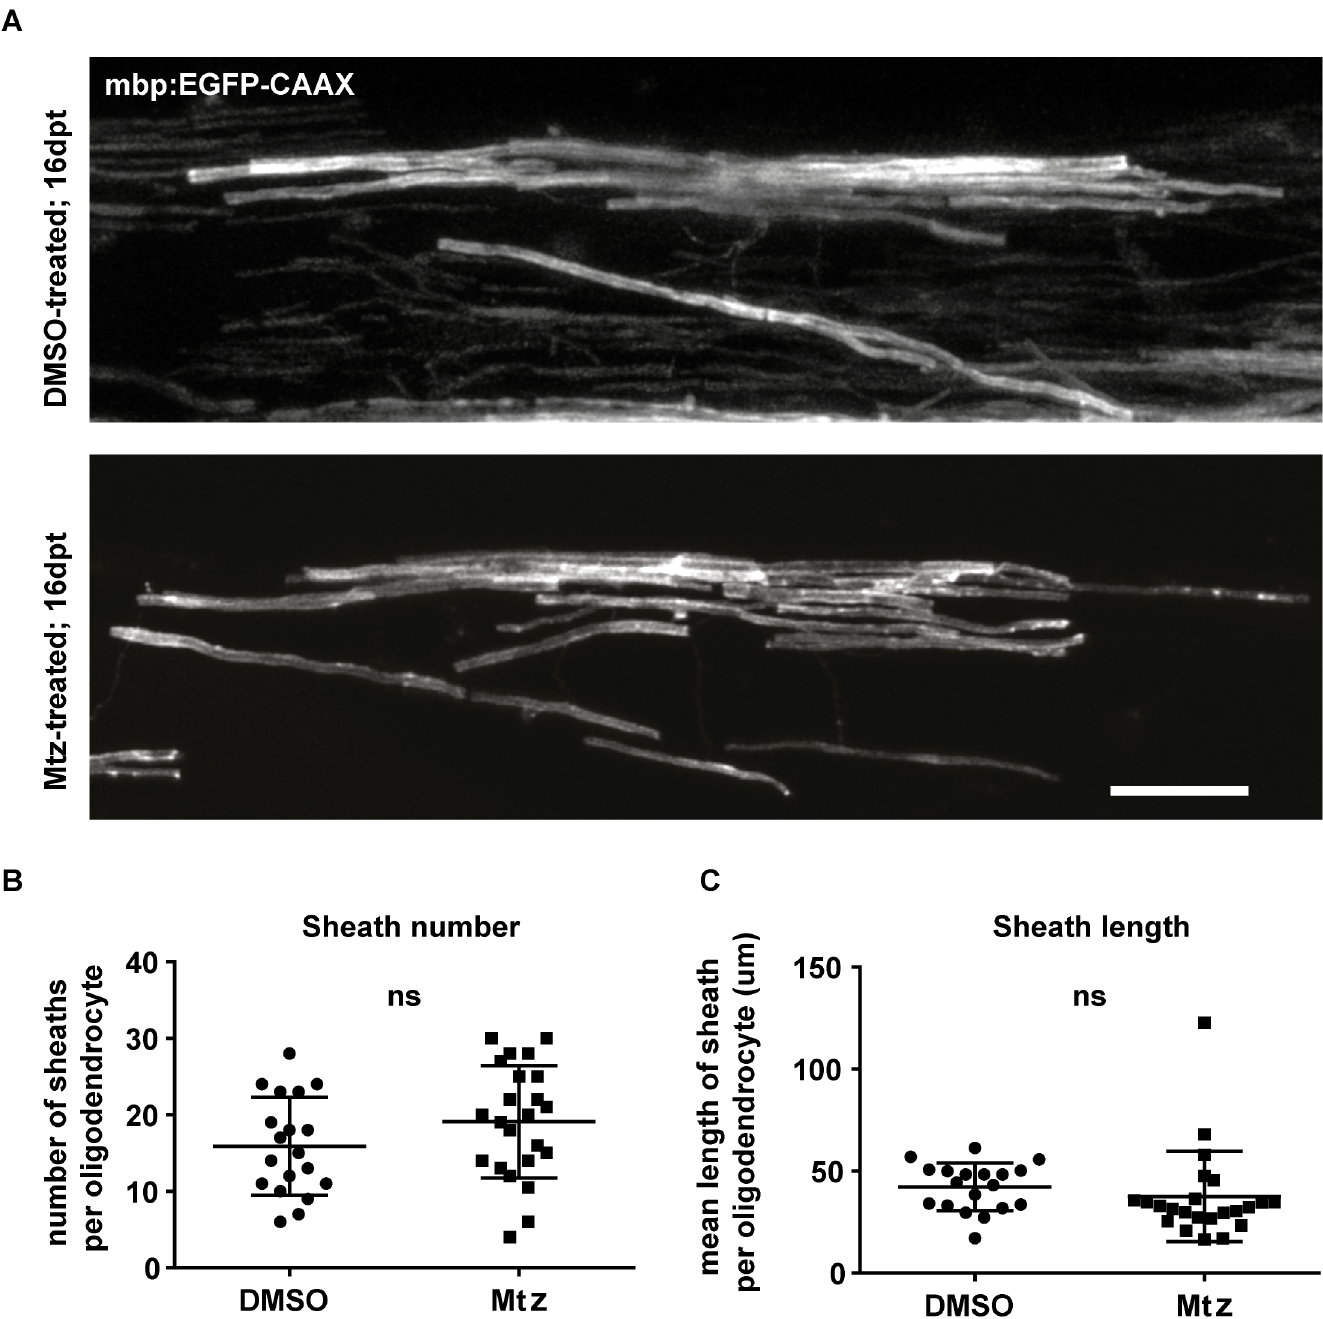
Fig 8. Myelin sheath numbers and lengths per oligodendrocyte are not different between control and treated animals at the remyelinated stage. A . Representative images of single oligodendrocytesin DMSO- or Mtz-treated Tg(mbp:mCherry-NTR) fish, labelledwith mbp:EGFP-CAAX. Scale bar: 20 μ m. B . Quantification of the mean number of sheaths per oligodendrocyte in control and Mtz-treated animals: in controls: 15.89 ± 6.39, vs treated: 19.11 ± 7.36, p = 0.143 (t test). C. Quantification of the mean length of myelin sheath per oligodendrocyte: mean in controls. Mean lengthof sheath per oligodendrocyte; in controls: 42.21 ± 11.64 vs treated: 37.41 ± 22.14, p = 0.400. n = 19 cells (in 16 animals)for controls, 23 cells (in 19 animals)for treated animals.